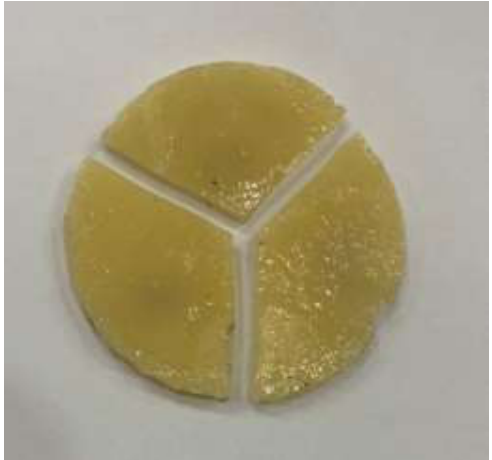
Figure 8: Broken specimen after pistons on three balls test.